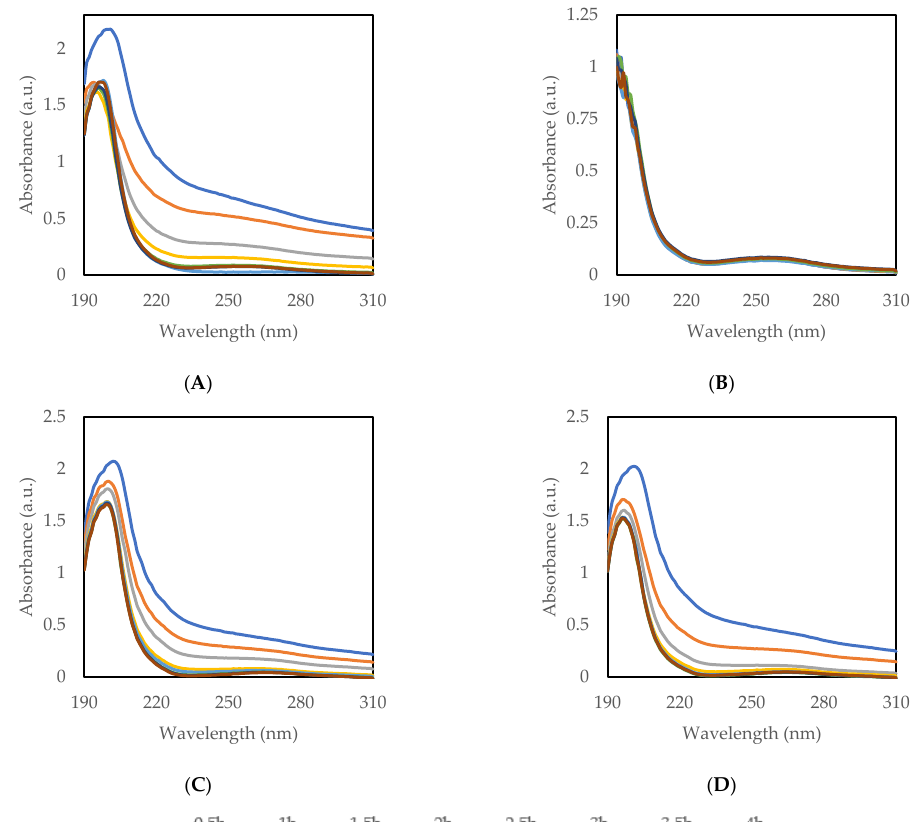
Figure A7. The UV-Vis spectra of samples after 24 h incubation at 20 °C. ( A ) chitin powder, ( B ); chitosan powder, ( C ) chitin nanocrystals (ChNC), ( D ) deacetylated chitin nanocrystals (D-ChNC).